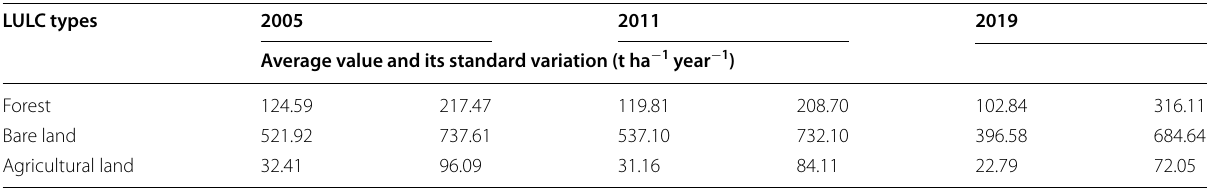
Soil erosion rate of water and built-up land is zero